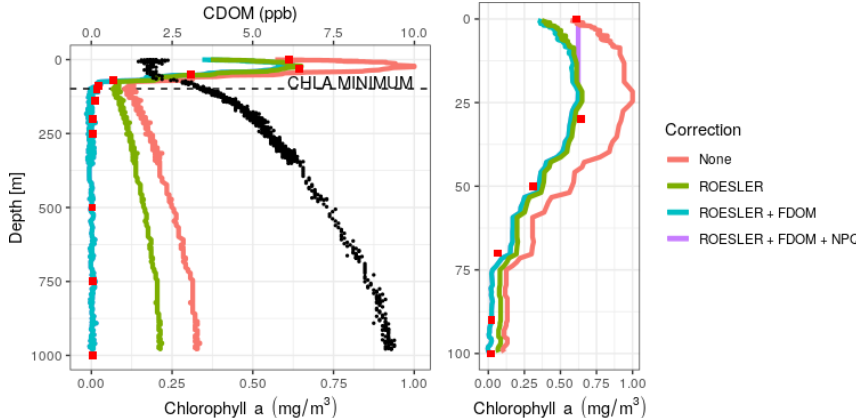
Figure 2. Vertical chl a profiles obtained at the deployment of the float 6903240 on 29 March 2018 at 49 ◦ 10 (cid:48) N and 29 ◦ E, using different levels of correction. HPLC data are depicted as red squares and CDOM as black dots. Right panel: zoom of the surface layer.